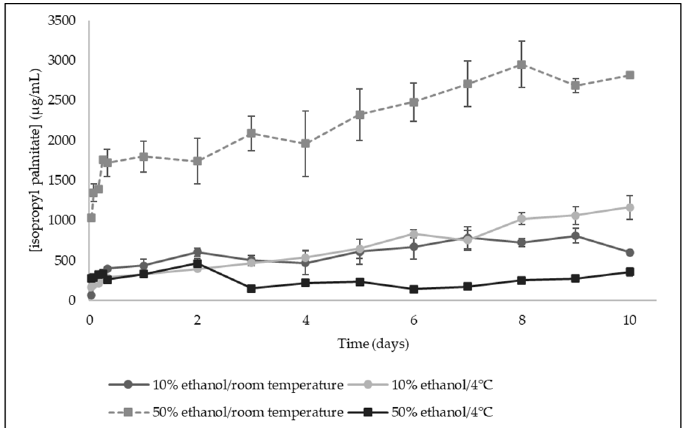
Figure 5. Release kinetics of isopropyl palmitate from bilayer films to food simulants (10% ethanol and 50% ethanol) at room temperature and 4 °C (Results expressed as mean ± SD).